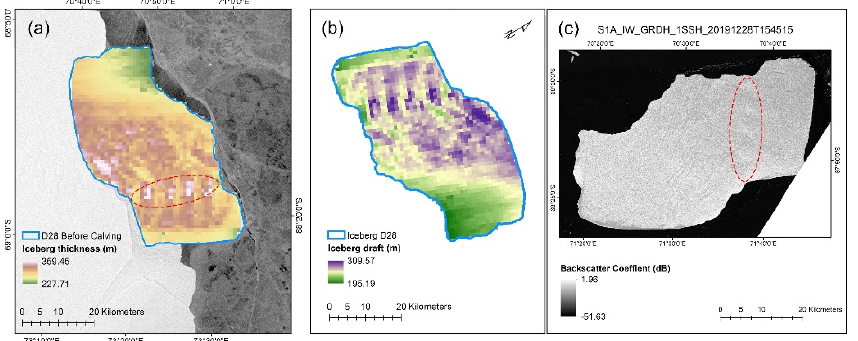
Figure 4. ( a ) Thickness map and ( b ) draft map of iceberg D28. ( c ) A Sentinel-1 SAR image obtained on 28 December 2019. The topographic relieves shown by the thickness map and the satellite image are marked by the red ellipses.